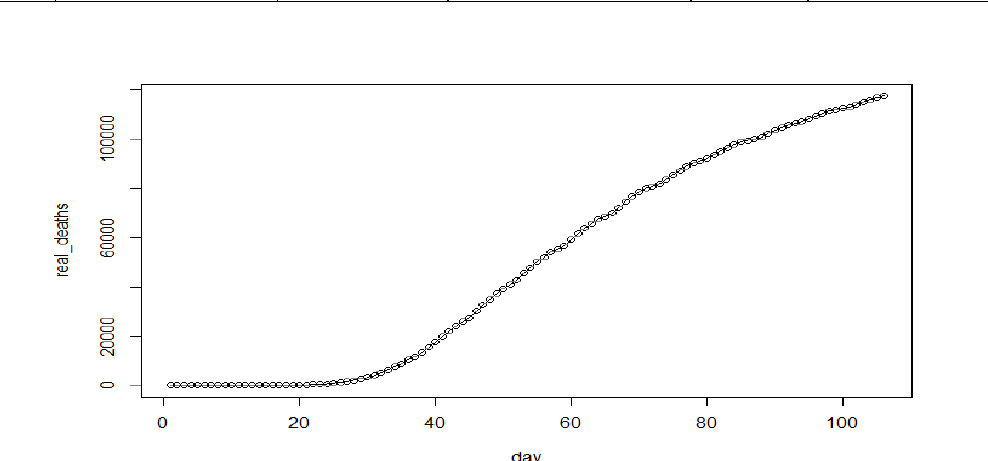
Figure 1. Total death toll vs day in the United